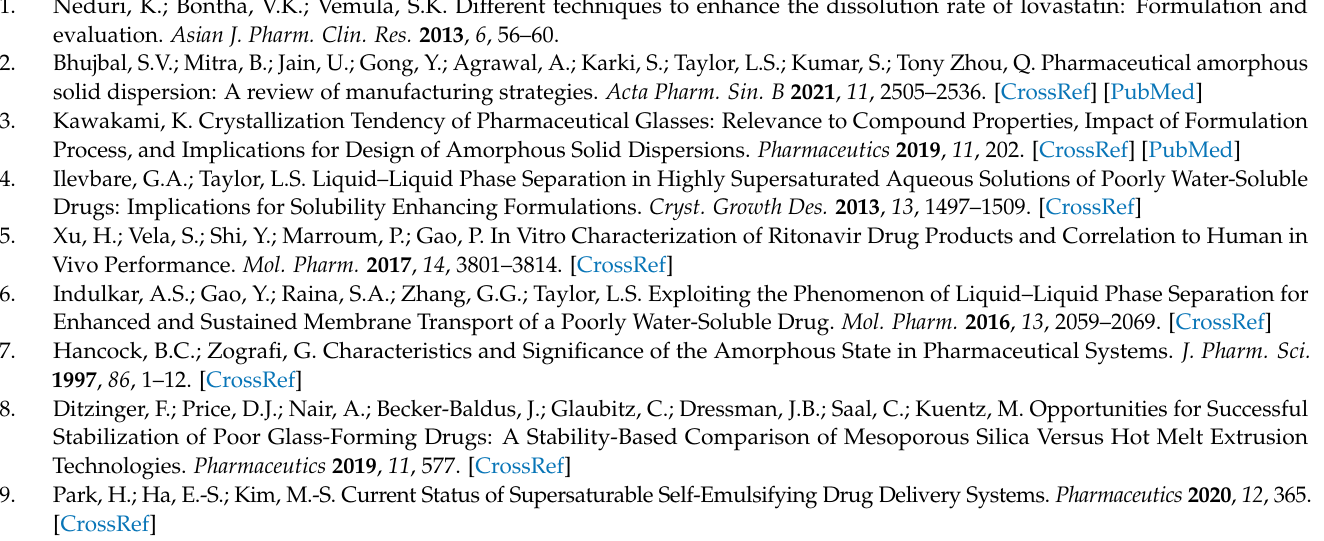
Figure S2: The dissolution of the ritonavir ASD formulation without the addition of Span 20 in the 900 ml aqueous medium using USP dissolution apparatus II; Figure S3: The PXRD of ritonavir Form I and Form II; Figure S4: The DSC of ritonavir ternary ASD formulations prepared by solvent evaporation; Figure S5: The infrared spectrum of ritonavir Form II; Table S1: PDI index of the particle size